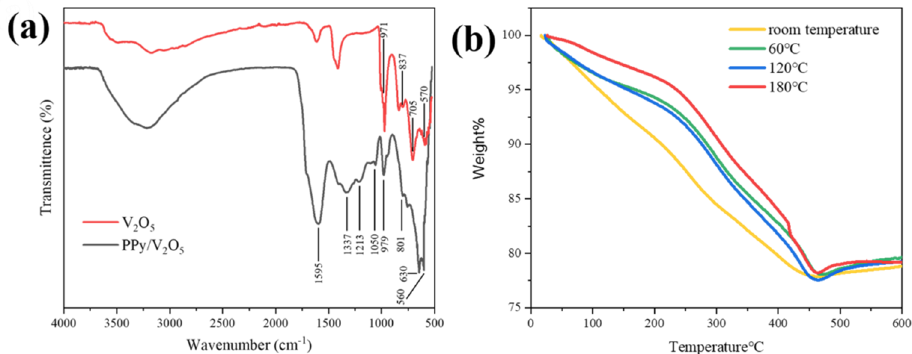
Figure 3. ( a ) FTIR spectra of V 2 O 5 and PPy/V 2 O 5 composites. ( b ) TGA curves of PPy/V 2 O 5 composites synthesized at different temperatures.